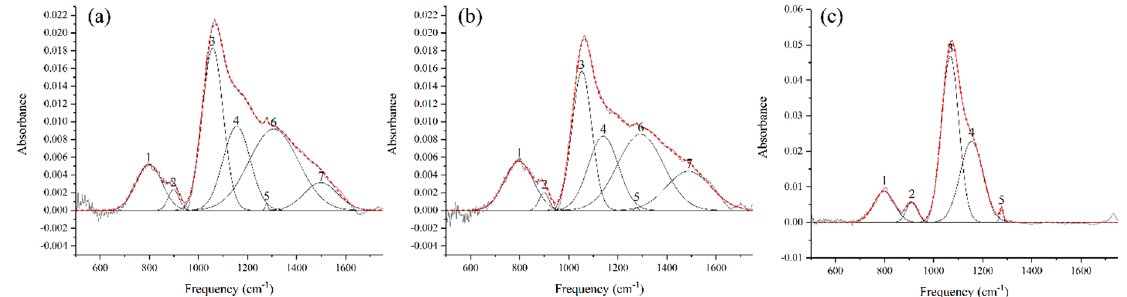
Figure 10. Synthetic curve models developed on the Fourier transform infrared spectroscopy (FTIR) spectra acquired for ( a ) PT3, ( b ) PT5, and ( c ) PT5P75.